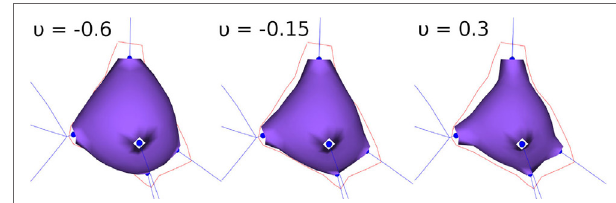
FIGURe 3 | FEM deformation. Variations of Poisson’s coefficient resulting in variations in soma volume.